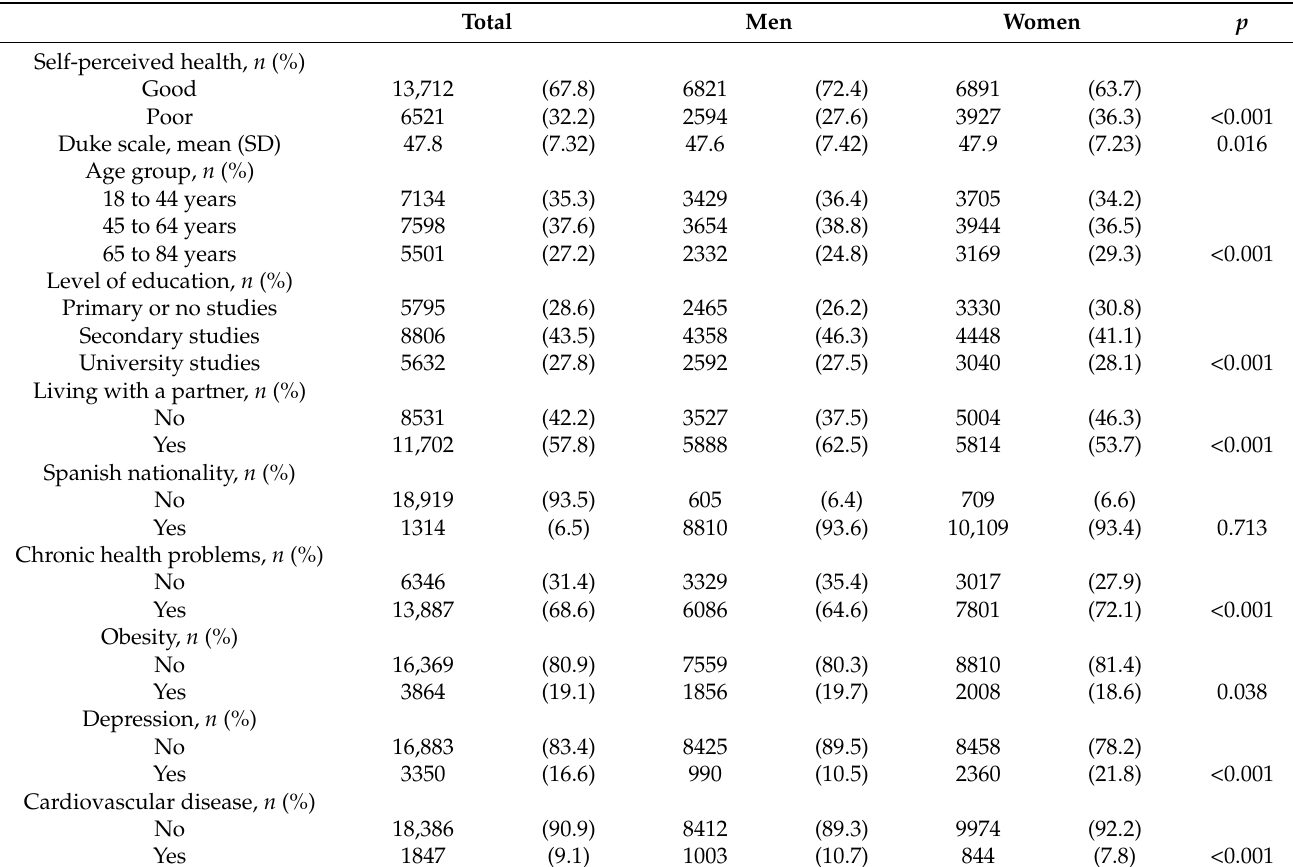
Table 1. Description of the study variables. Adult men and women. 2017 Spanish National Health Survey. Total